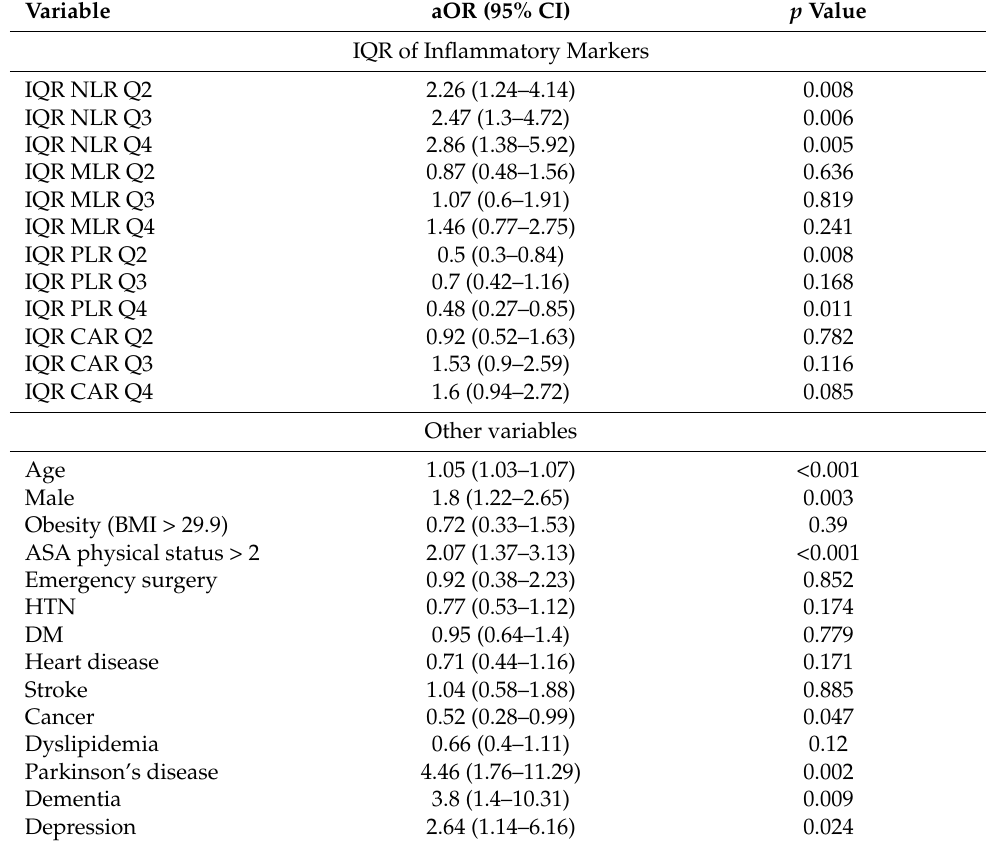
Table 4. Multivariate logistic regression analysis showing the effect of inflammatory markers and other variables on the likelihood of POD